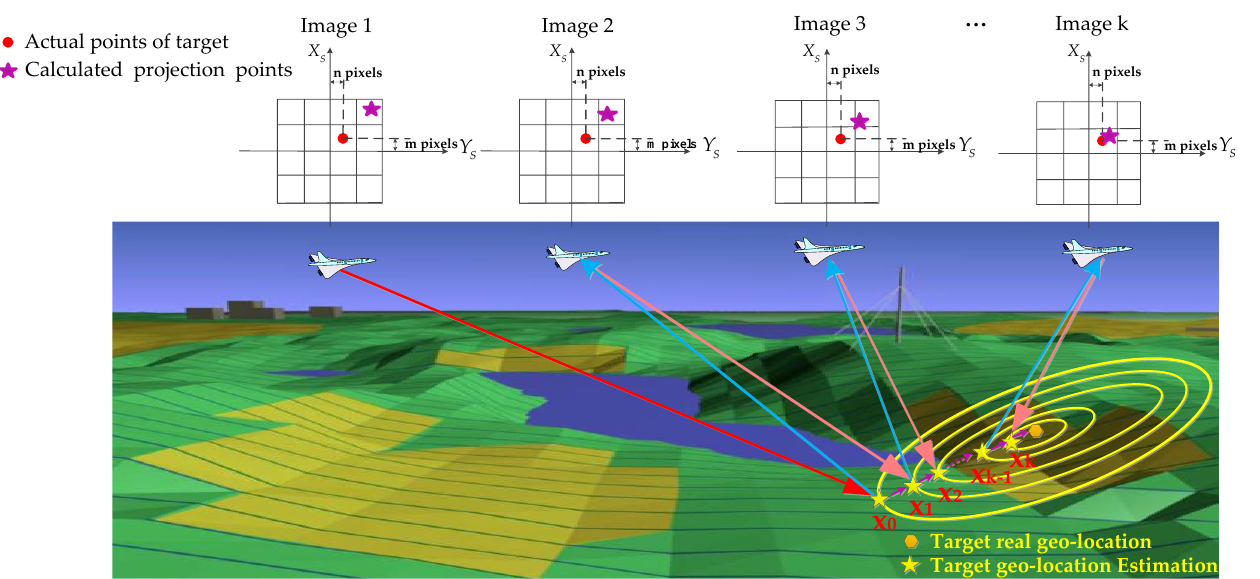
Figure 5. The proposed work pattern.